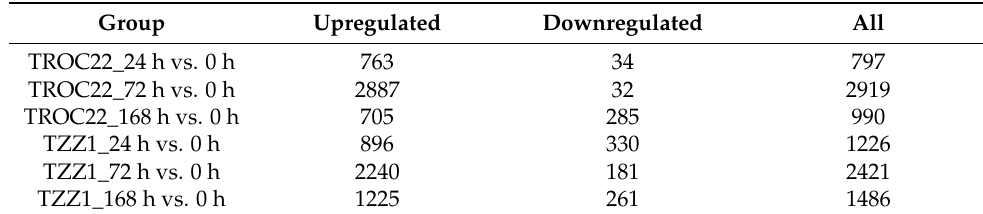
Table 1. Statistics of differentially expressed genes.